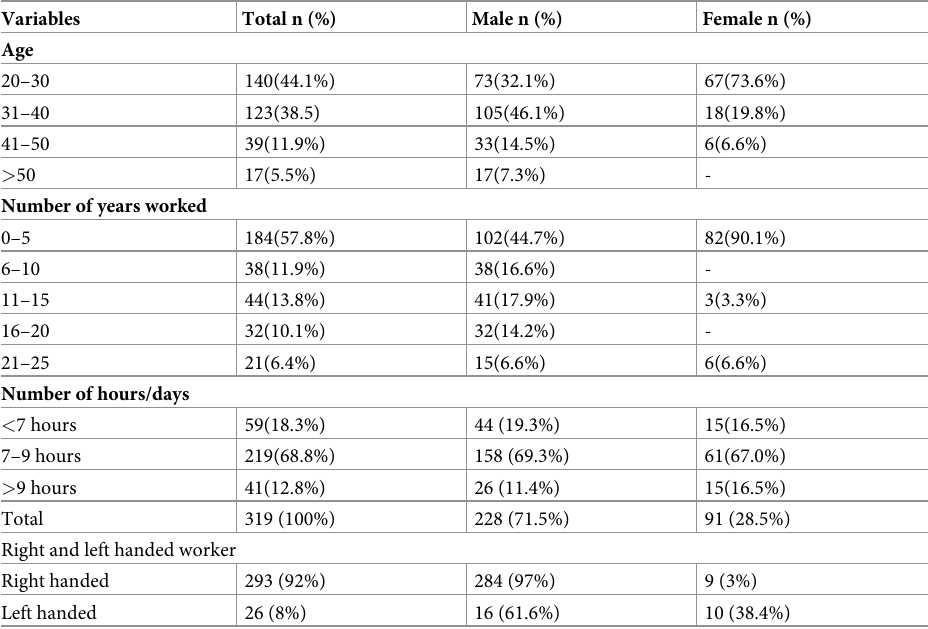
Table 1. Characteristics of the study participants.